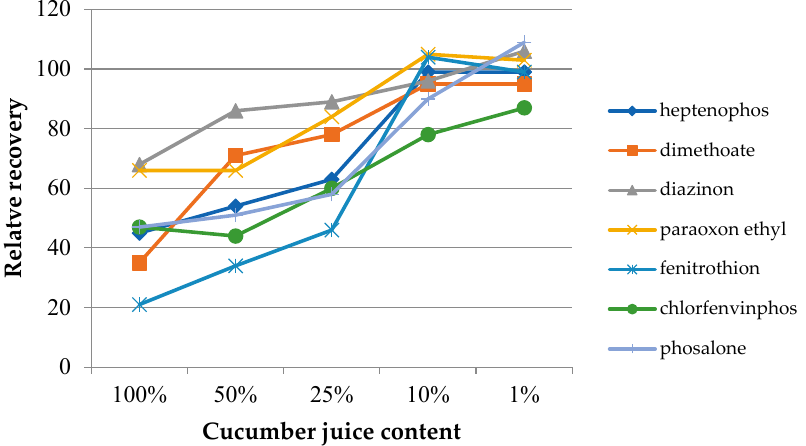
Figure 7. Effect of diluting the samples with ultrapure water at different dilution ratios ( v / v ) utilizing the IL-2 fiber for the extraction of cucumber juice.